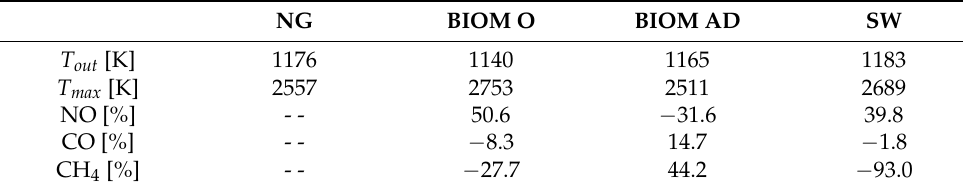
Table 3. Computational results